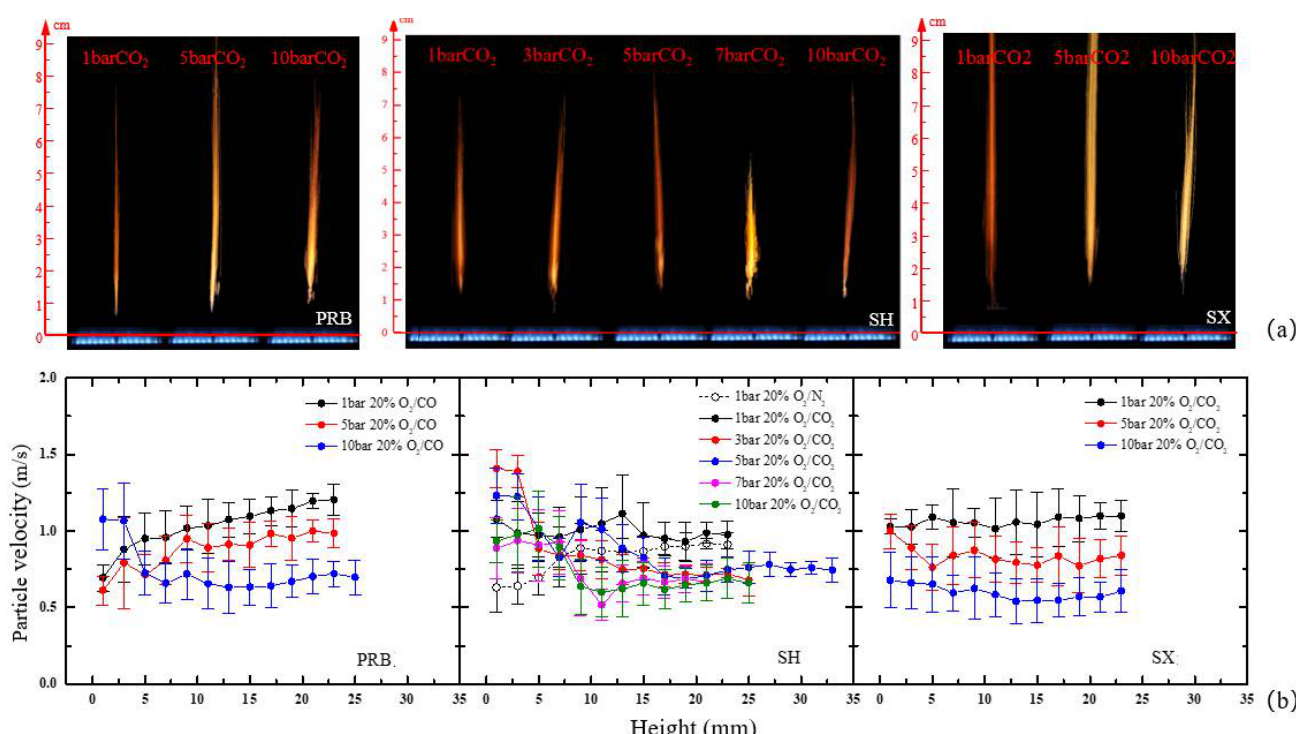
Figure 10. ( a ) Long-exposure images of three kinds of pulverized coal under different pressures; ( b ) particle velocity of three kinds of pulverized coal under different pressures.